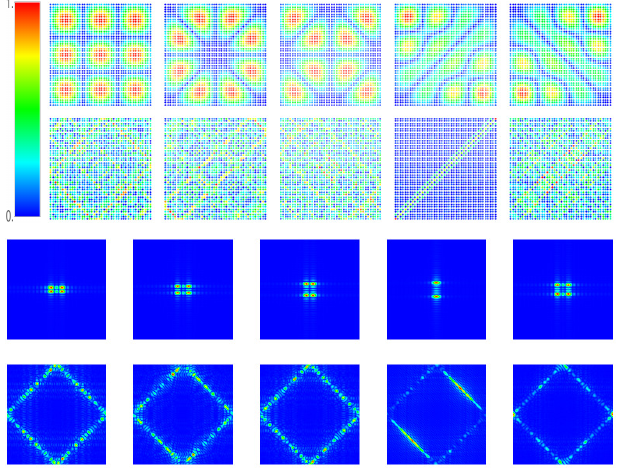
Figure 4. Square lattice with n 1 × n 2 = 42 × 42 sites. Squared wave functions (two upper rows) and momentum distributions (two lower rows) of states ν = 16 − 20 at the lower band edge (first and third row, respectively) and ν = 877 − 881 around the van Hove singularity at ν (cid:39) 882 (second and fourth row,